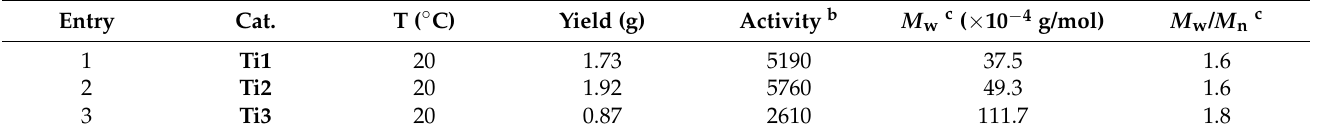
Table 4. Ethylene polymerization with Ti1 - Ti3 /DMAO system in the presence of 1.0 equiv. of pyrene a .